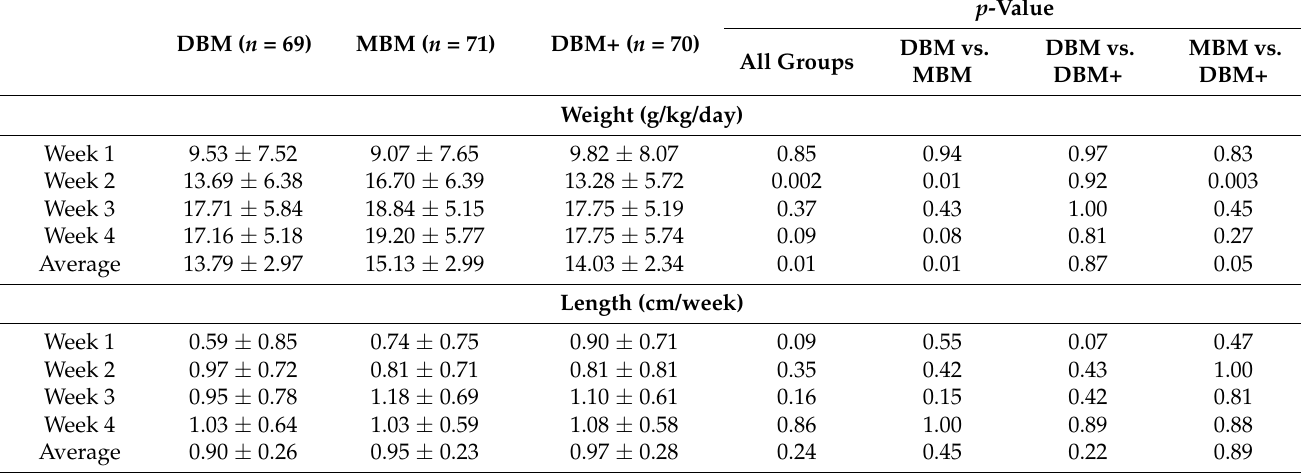
Table 4. Group comparisons of weekly growth